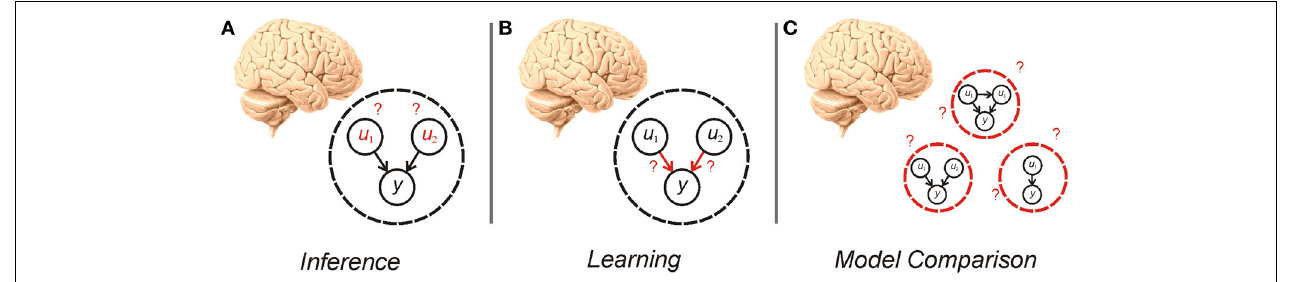
FIGURE 1 | Cartoon illustrating inference (A), learning (B), and model comparison (C). Inference requires an agent to alter its beliefs about the causes ( u 1 , u 2 ) of sensory data ( y ) to maximize model evidence (minimize surprise). Learning also involves the maximization of model evidence, this